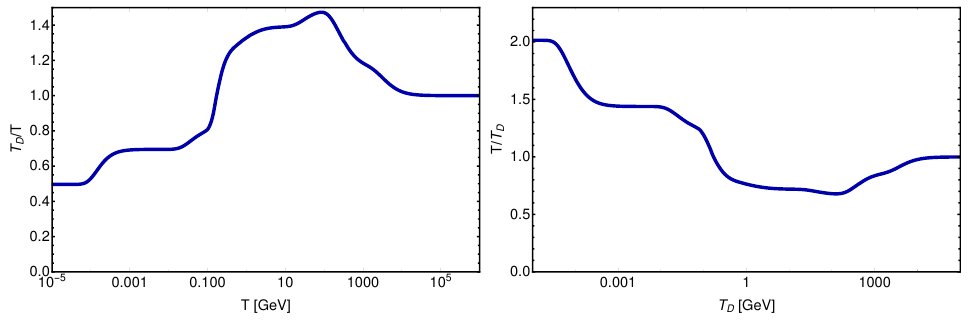
/ T , as D = 10 TeV and m = 1 TeV, calculated p e for the same choice D